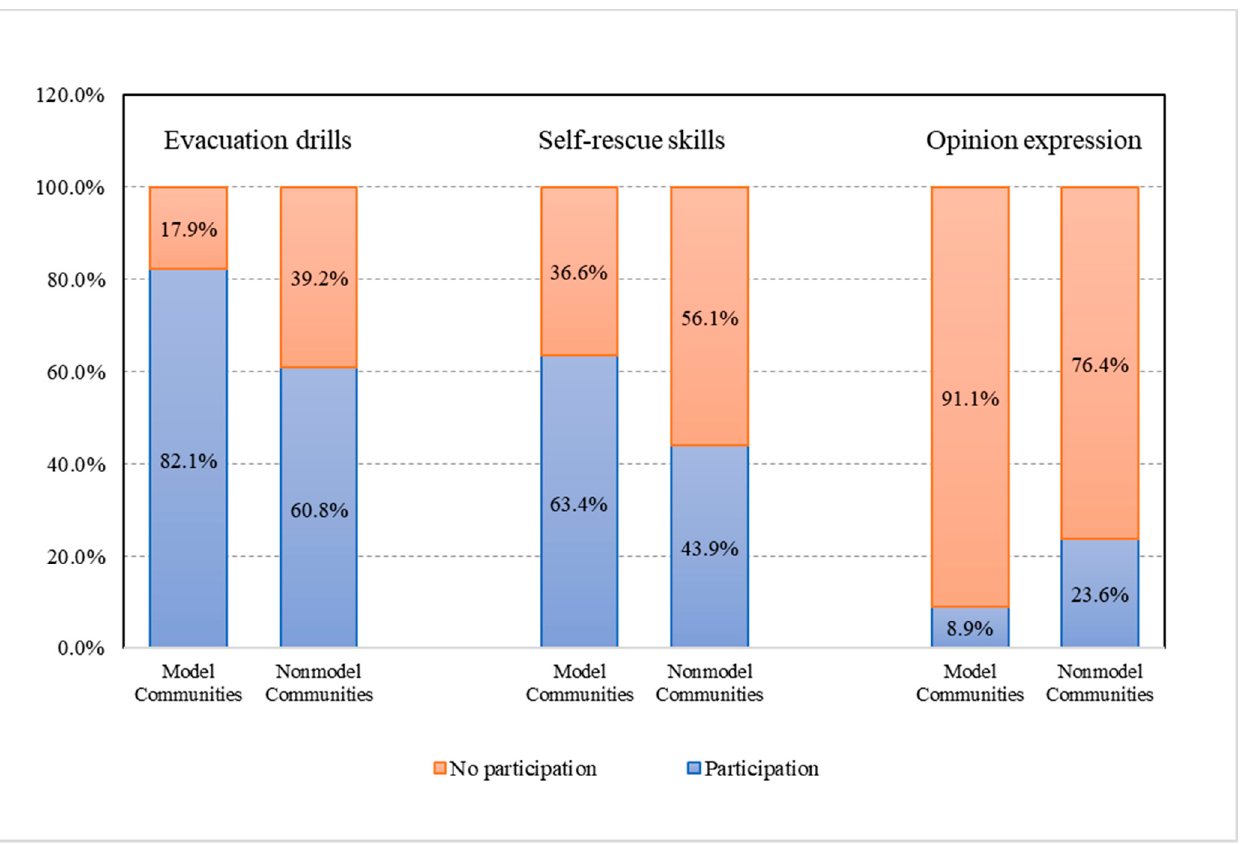
Figure 3. Percentage of public participation in disaster mitigation activities in model and nonmodel communities (%).